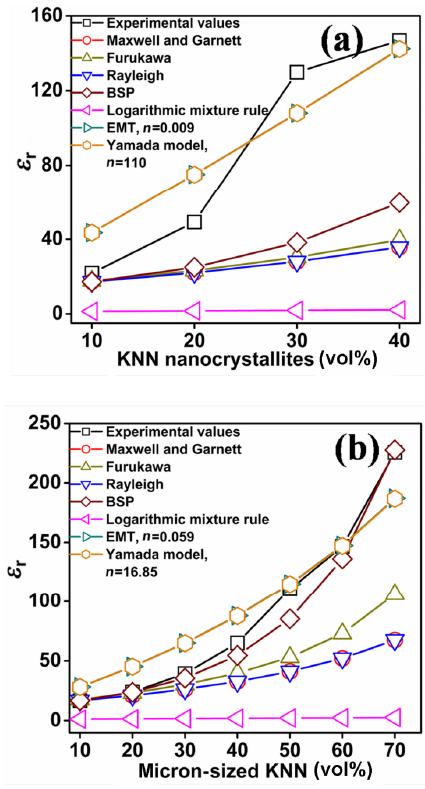
Fig. 7 Variation of the dielectric constant (  r ) measured at room temperature and a frequency of 10 kHz: (a) PVDF–KNN nanocrystal composites and (b) PVDF–KNN microcrystal composites. For comparison, corresponding theoretical values obtained using various models are also